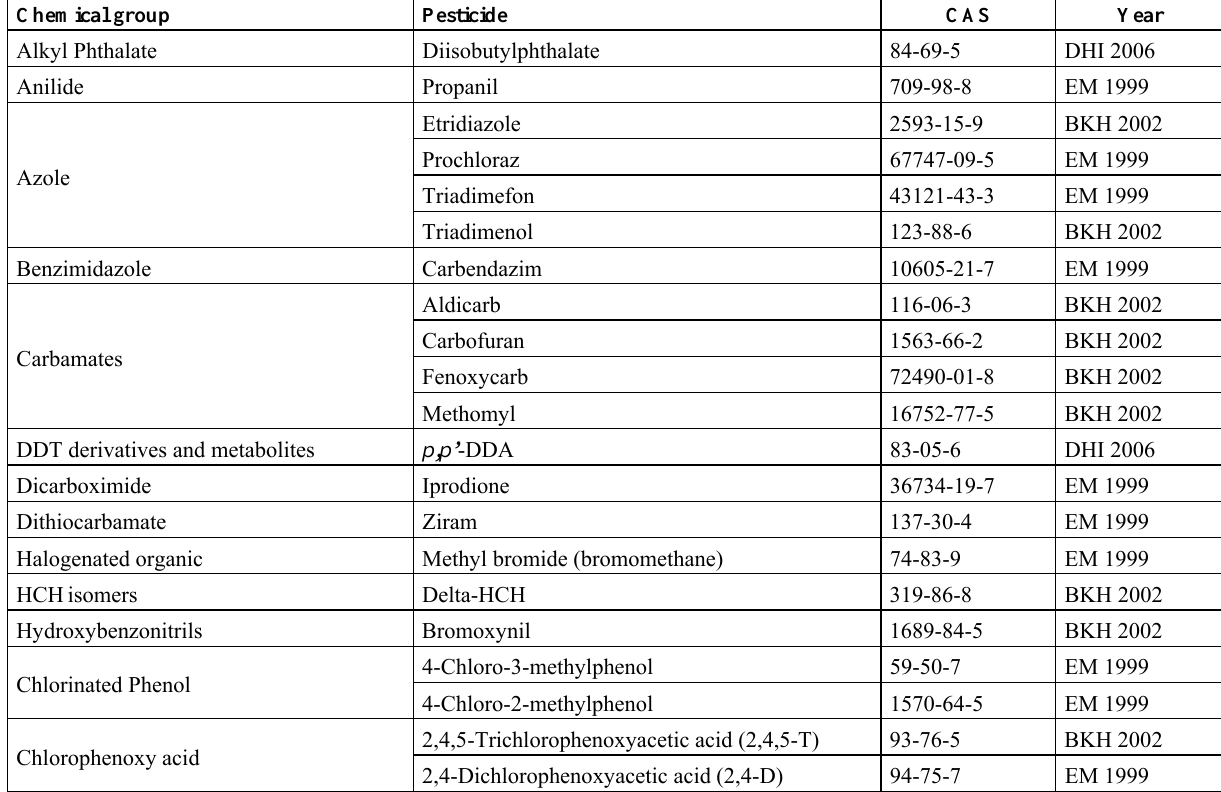
Table 2. Potential endocrine disrupting pesticides—Category